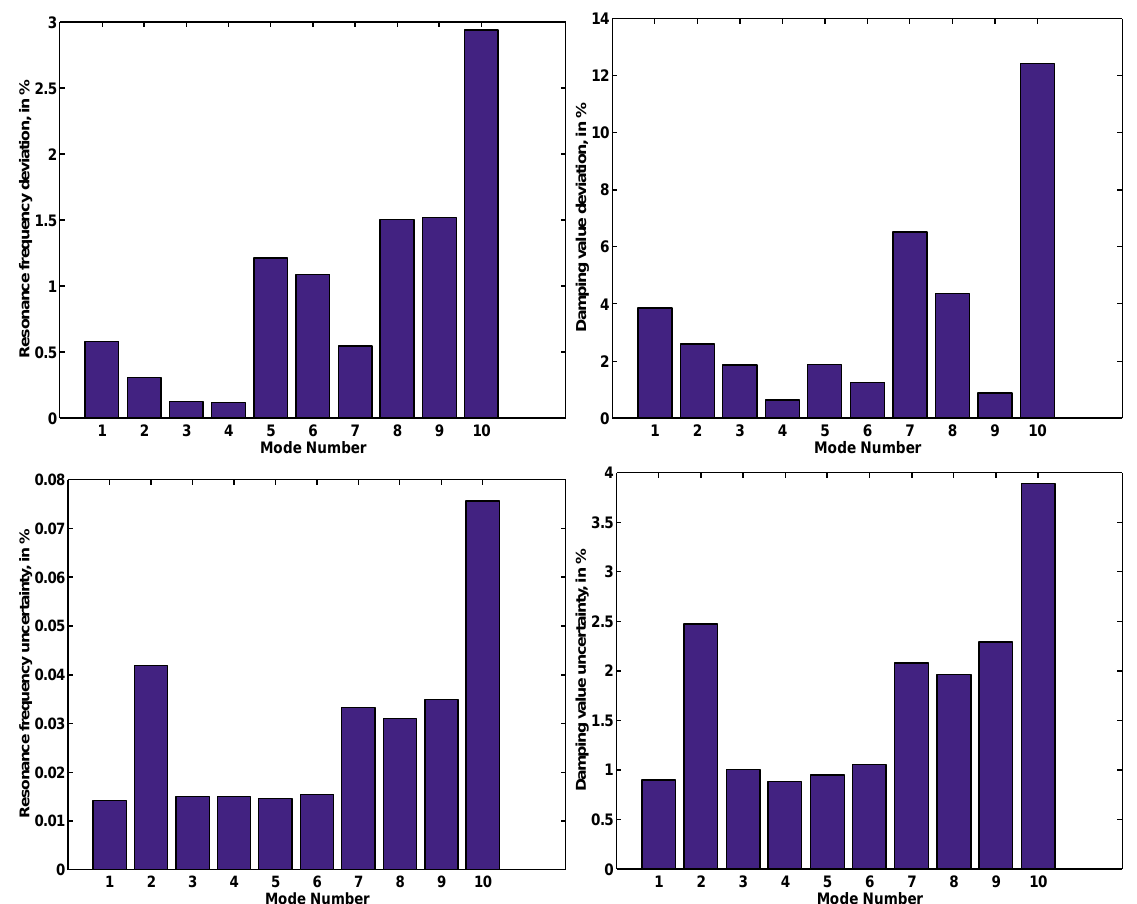
Fig. 6. Relative change of resonance frequencies (left) and damping values (right) between damaged and undamaged states (top) and uncertainty on resonance frequency and damping value estimates (bottom). Both estimates and uncertainties are computed using the proposed MLEprocedure (Section